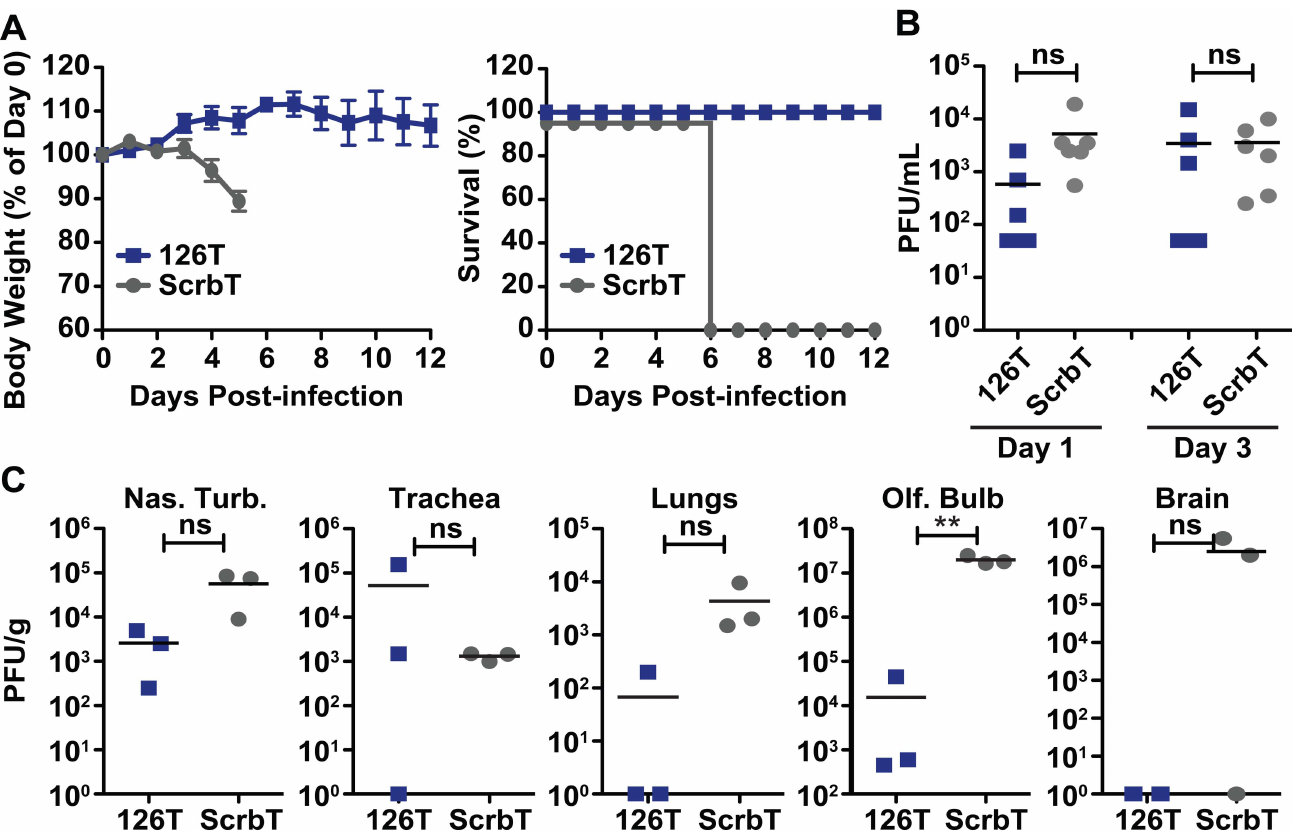
Fig 6. Restriction of H5N1replication in endothelial cells ameliorates disease symptoms in ferrets. Five-month old male finch ferrets that tested seronegative for circulatinginfluenza viruses were intranasally infected with a 3500PFU dose (n = 6/group)of the H5N1viruses, and monitoredfor weight loss and clinicalsigns of infection. (A) Weight loss and survival of infected ferrets. On day 5 pi, H5N1-ScrbTinfected ferrets showedsevere signs of neuronalinfection and were humanely euthanized. (B) Viral loads in the nasal washes. Nasal washeswere performed on day 1 and 3 pi and viral titers were determinedby plaqueassay. (C) Viral replicationat different sites in the respiratory tract and brain. On day 4 pi, three ferrets from each group were euthanized and different organswere harvestedfor viral titer determination. Each data point represents the viral titer of an individualferret. The limit of detection is 10 PFU/mL. Asterisk denotesstatistical significance determinedby one-wayANOVA and the values are denotedas * P < 0.05, ** P < 0.01, *** P < 0.001 and ns–nonsignificant.Ferret experiment was performed once.